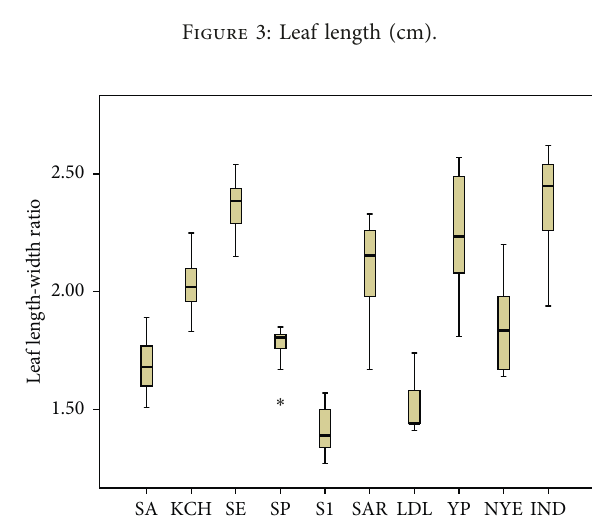
Figure 3: Leaf length (cm).